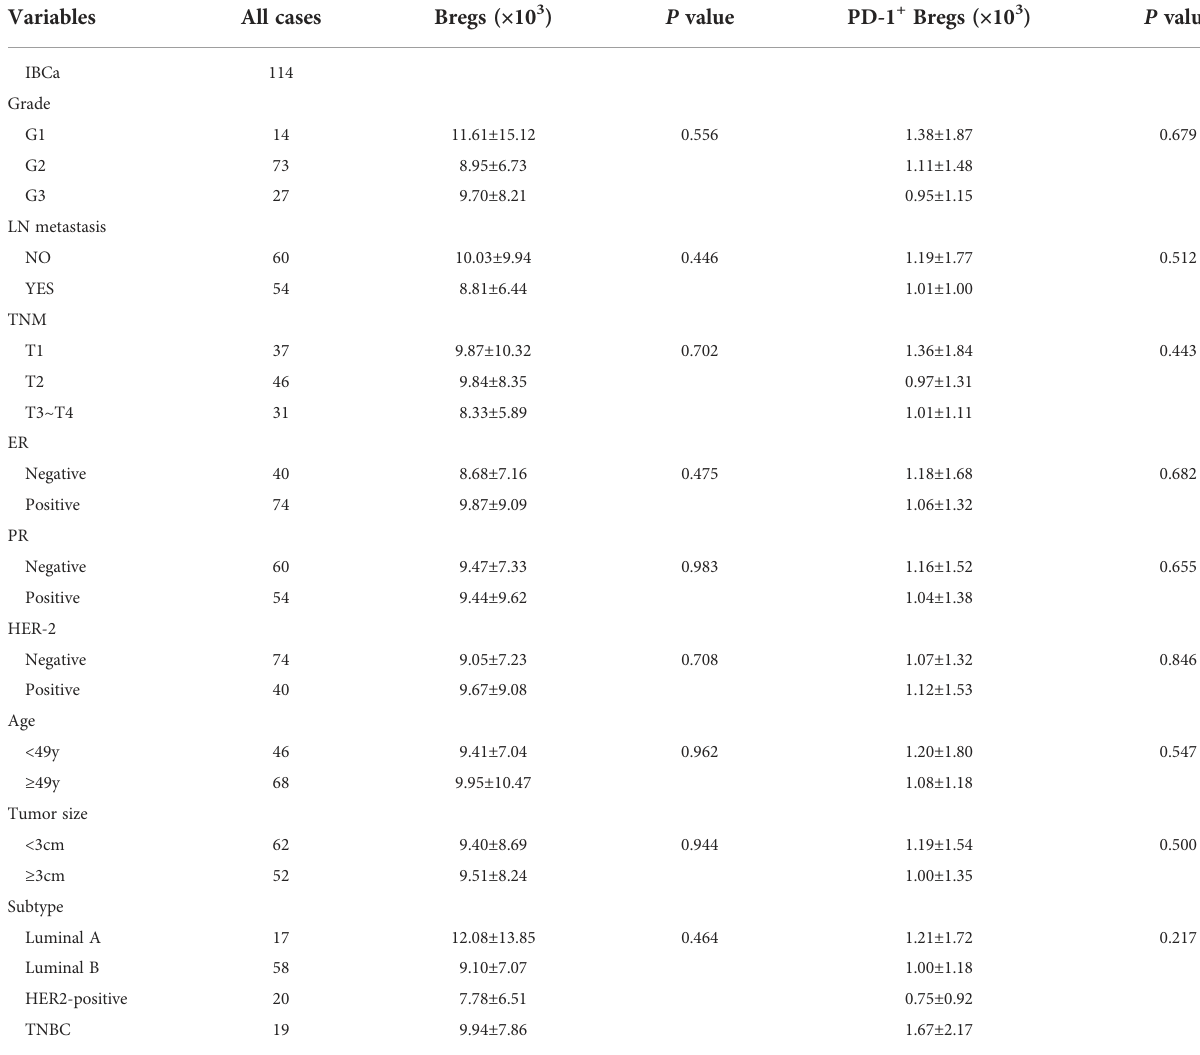
TABLE 4 Relationship between the absolute number of Bregs and its subset in PBMCs and the clinicopathological parameters of IBCa patients.